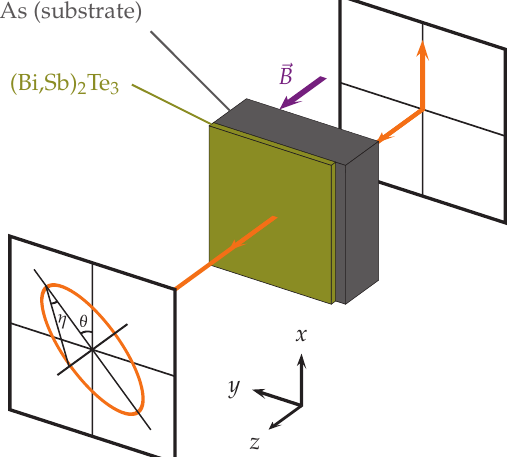
Figure 1. Scheme of the optical experiment. Linearly polarized incident light is transformed into the elliptical polarization after the sample, and is characterized by Faraday rotation angle θ and ellipticity η . The analyzer in front of the detector projects the ellipse either into the same direction as the incident beam leading to parallel transmittance t xx or to perpendicular direction leading to the crossed transmittance t xy . An external magnetic field is applied parallel to the propagation direction (Faraday